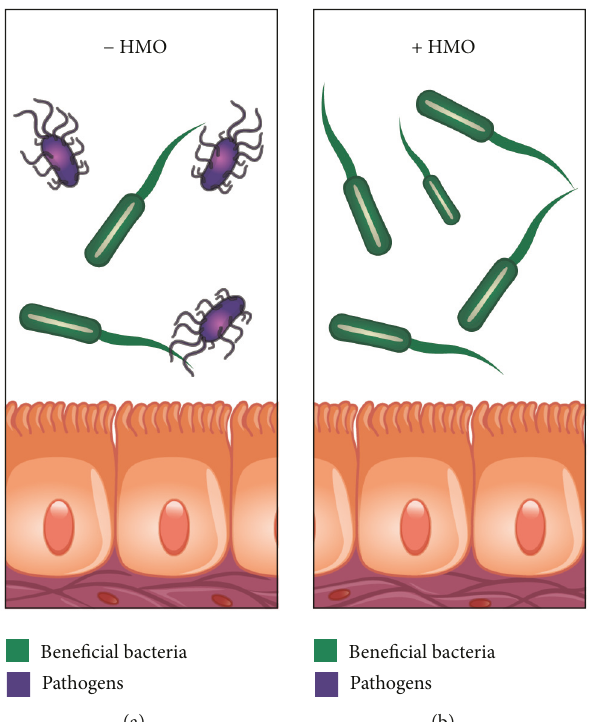
Figure 3: Type of gut microbiota in (a) absence of HMOs and (b) presence of HMOs. The growth of beneficial bifidobacteria is favoured by HMOs over that of pathogens in the